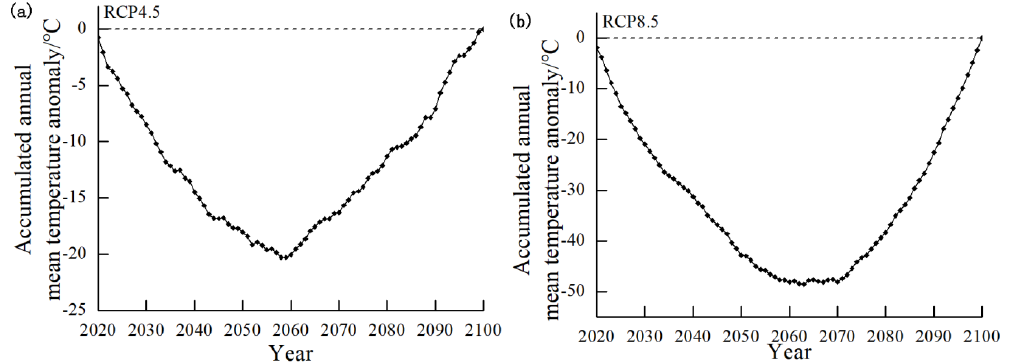
Figure 5. Accumulated annual mean temperature anomaly in the Lancang–Mekong sub-region under the RCP4.5 ( a ) and the RCP8.5 ( b ).